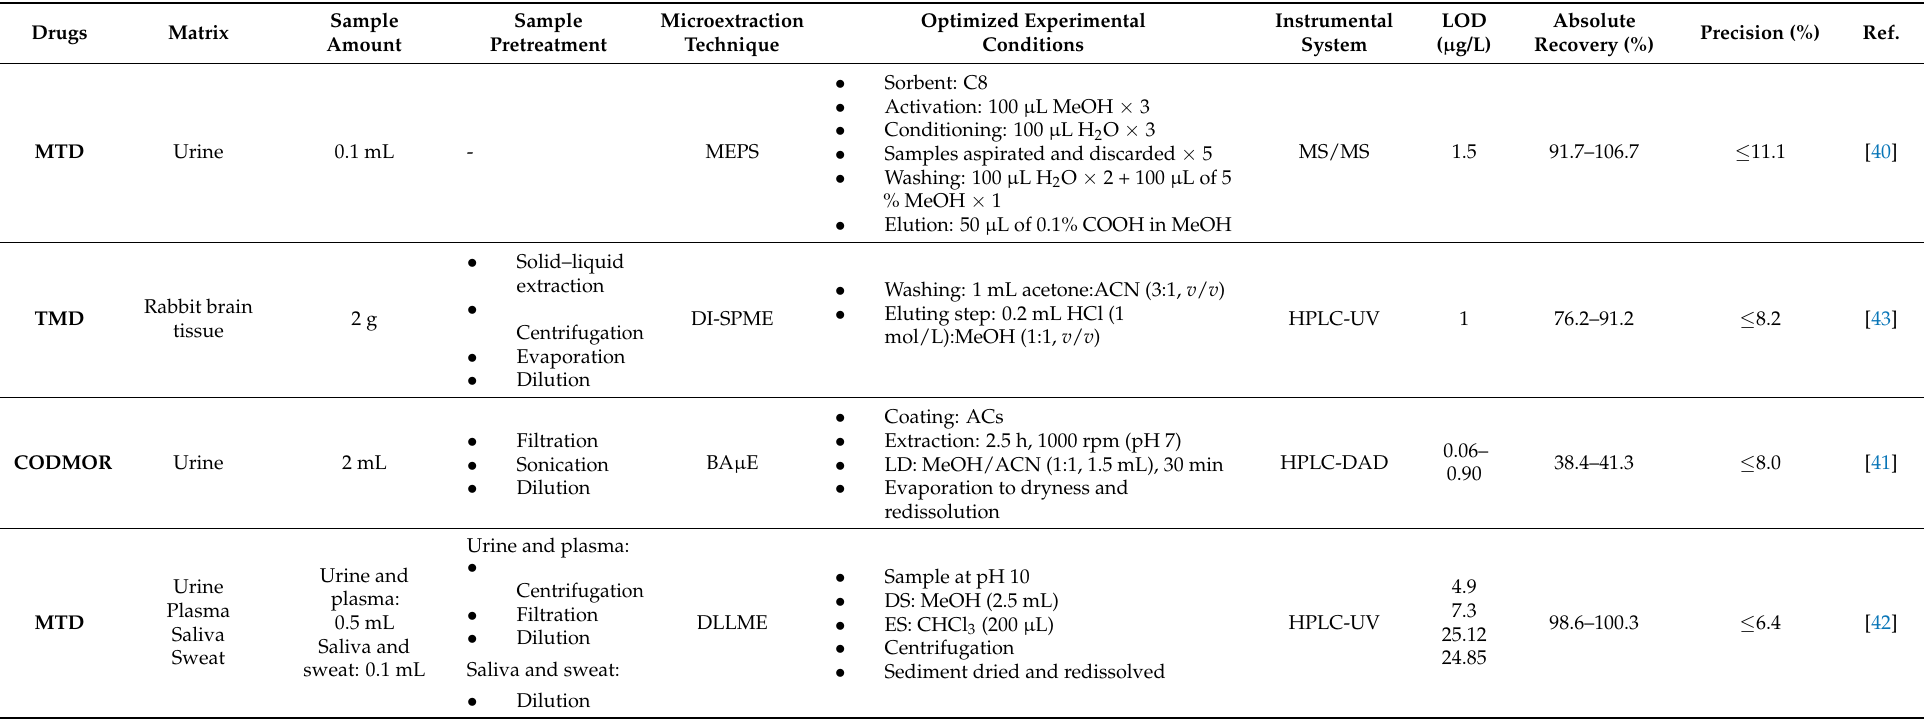
Table 1. Microextraction-based approaches for the analysis of opioids and related substances in the forensic